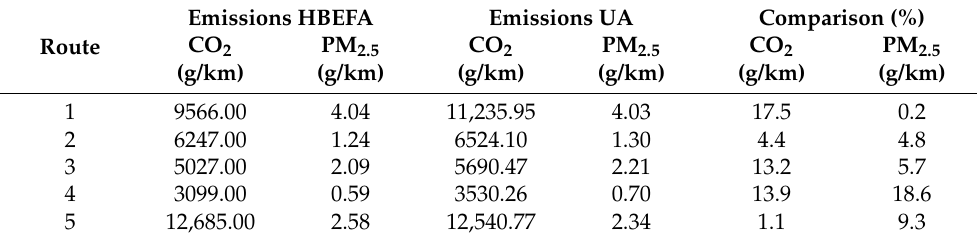
Table 5. Summary information